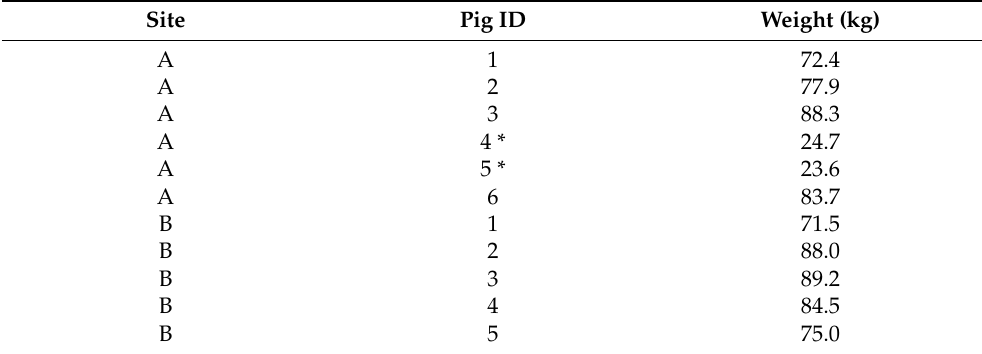
Table 1. Summary of the weight of each swine corpse at the moment of the inhumations. The * indicates the two samples that were inhumed together to simulate a twin